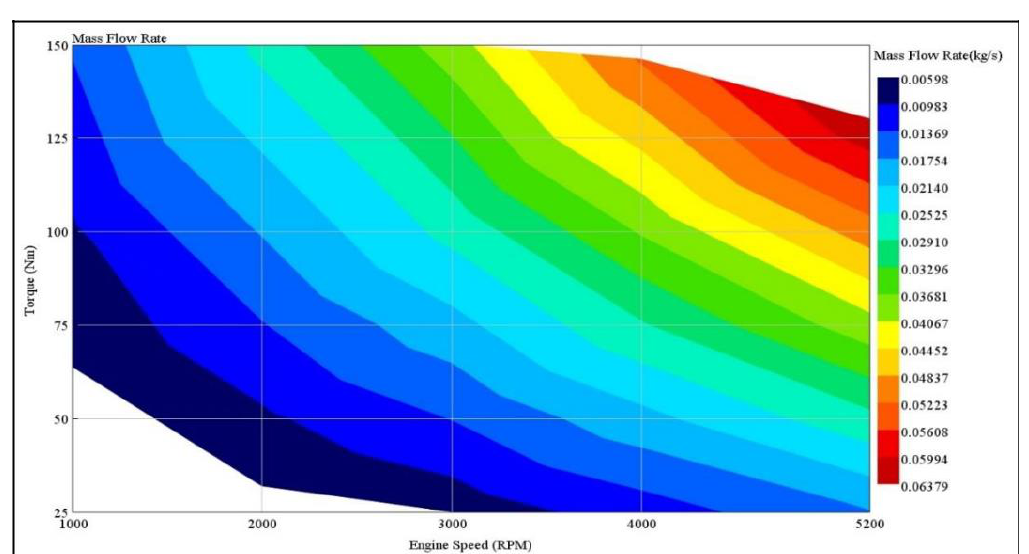
Figure 9. Exhaust pressure.